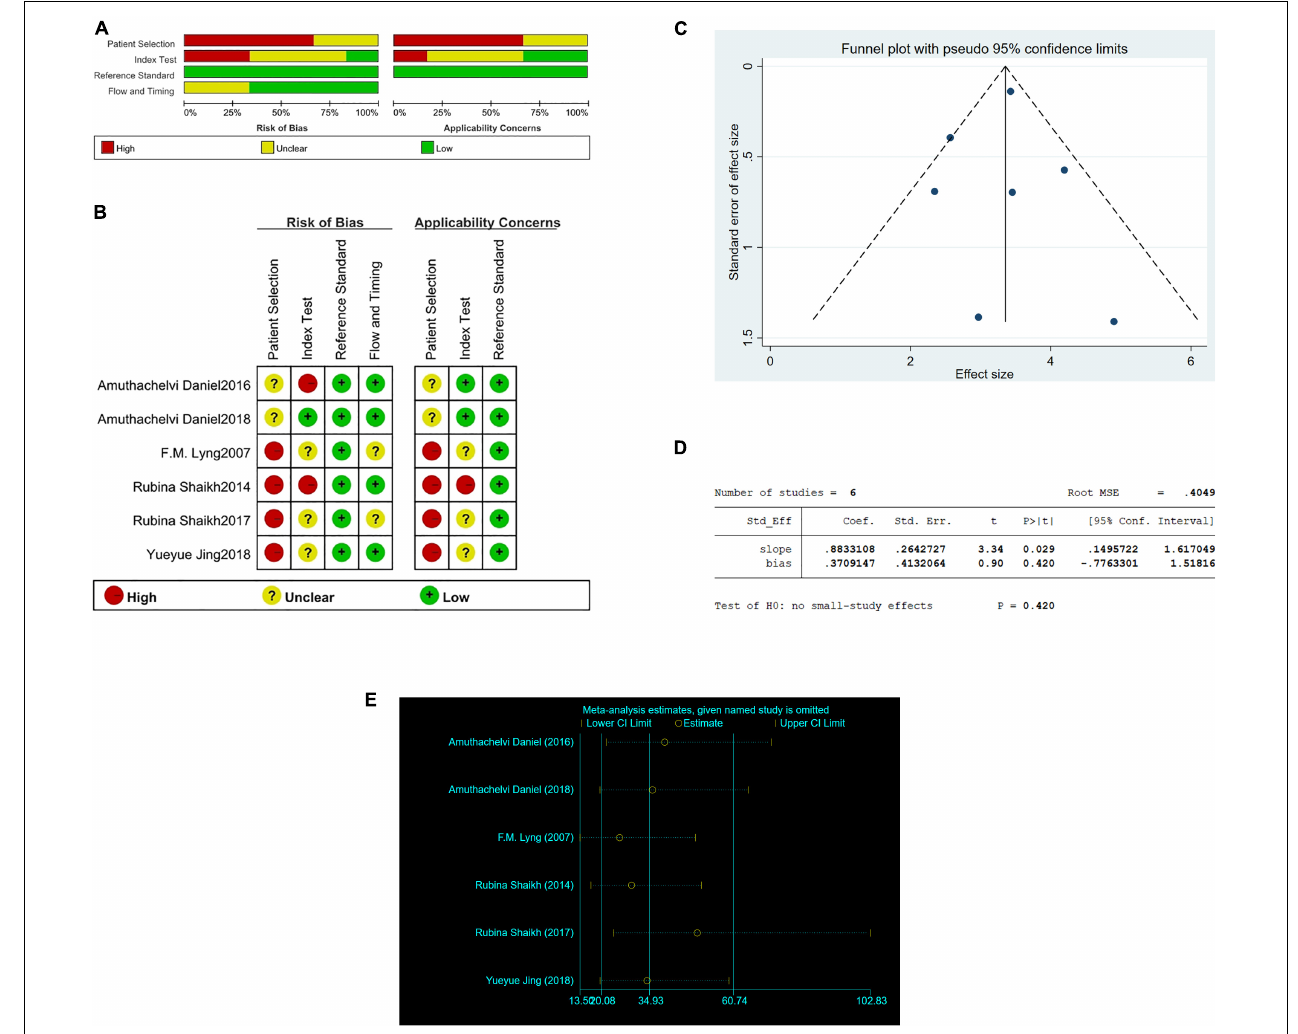
FIGURE 1 | The graphical display of the Quality Assessment of Diagnostic Accuracy Studies (QUADAS-2) of the included studies. (A) Risk of bias and applicability concerns evaluation of included studies in pool. (B) Risk of bias and applicability concerns evaluation of included studies individually. (C) Funnel plot of publication bias in Raman diagnosis of cervical cancer. (D) Egger’s regression test of publication bias in Raman diagnosis of cervical cancer. (E) Sensitivity analysis in Raman diagnosis of cervical cancer.